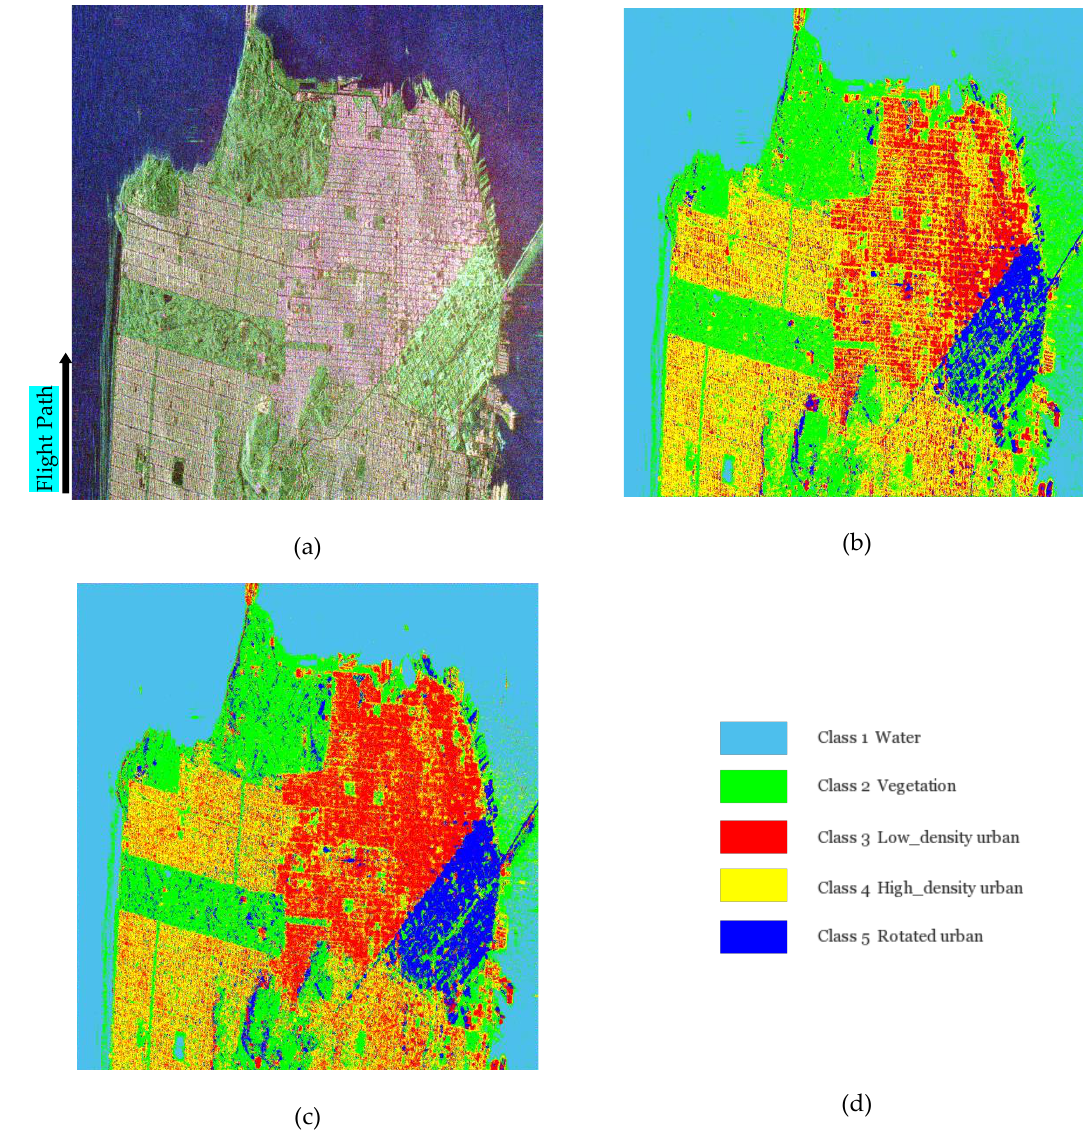
Figure 1. Classification results of the two mixture algorithms. ( a ) Pauli color-coded image. ( b ) Mixture Wishart for a whole image (MWW). ( c ) mixture Wishart for a class (MWC). ( d ) Class legend.